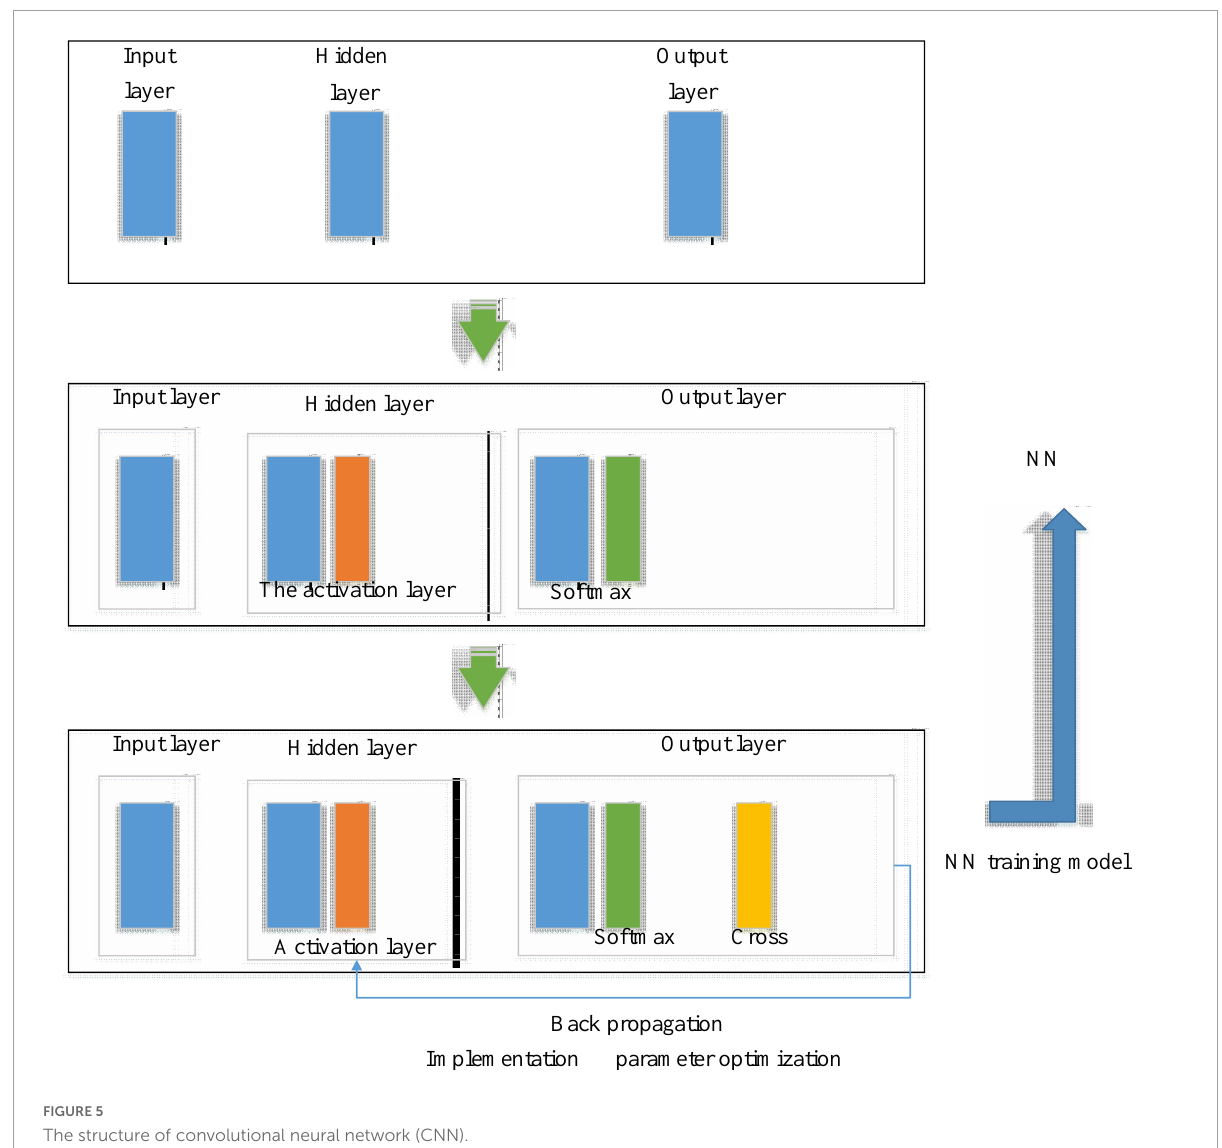
FIGURE5 The structure of convolutional neural network (CNN).